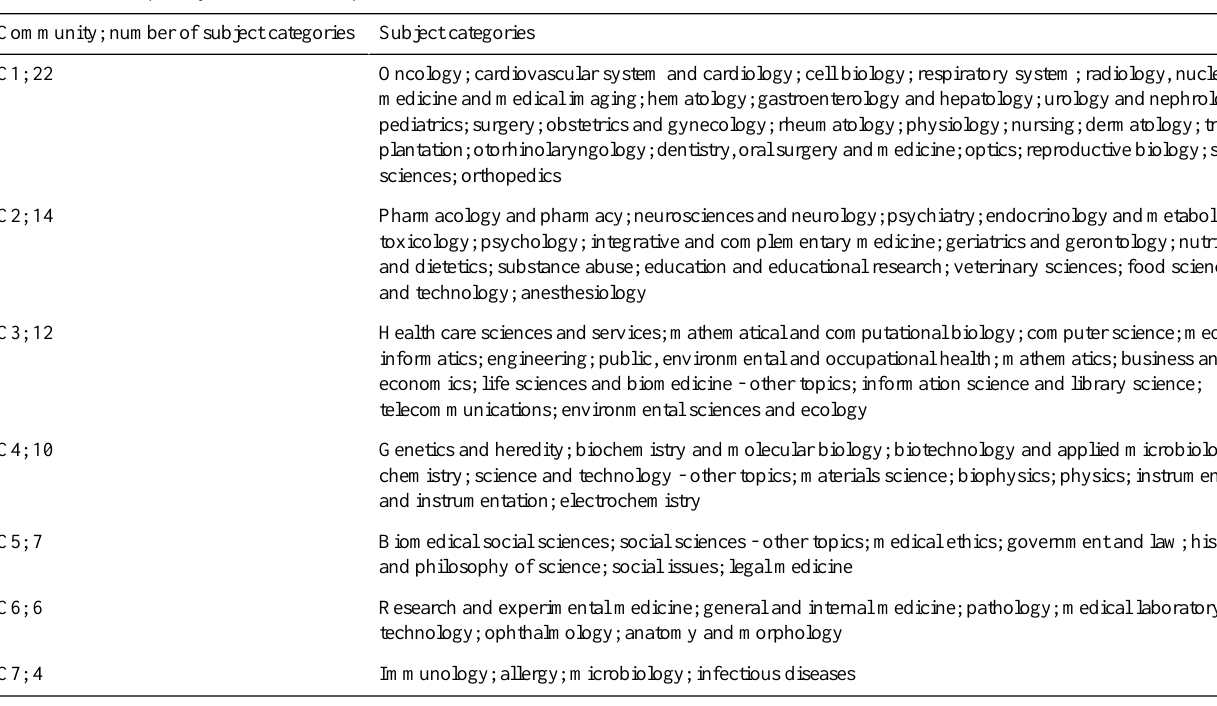
Table 5. Interdisciplinary communities of precision medicine research.